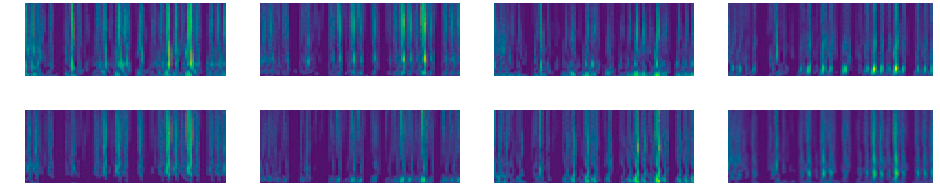
Figure 1. Time–frequency diagram of CSP filtered signal.